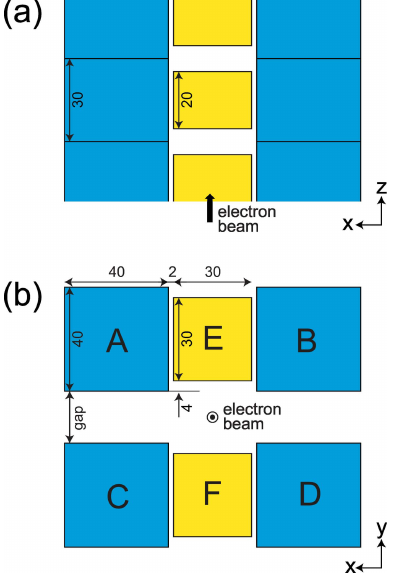
Figure 5 Dimensions (in mm) of magnet blocks in HEU120: ( a ) top view and ( b ) cross-sectional view.